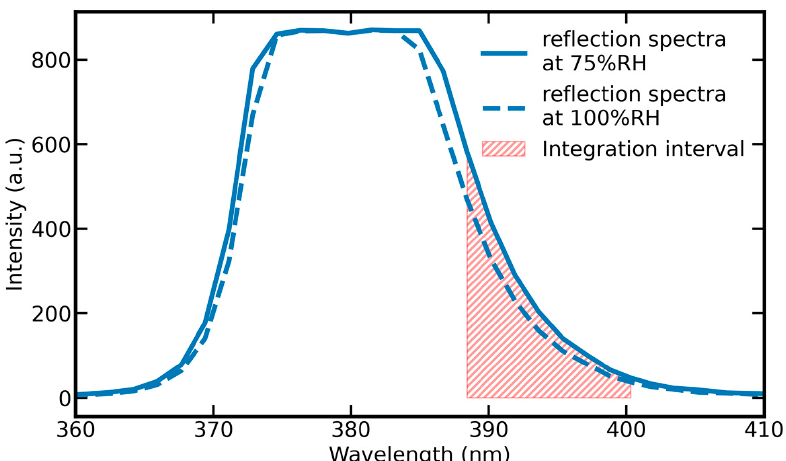
Figure 3. Raw reflected light spectra for RHs between 75% and 100% and the integration interval used between 388 and 400 nm.